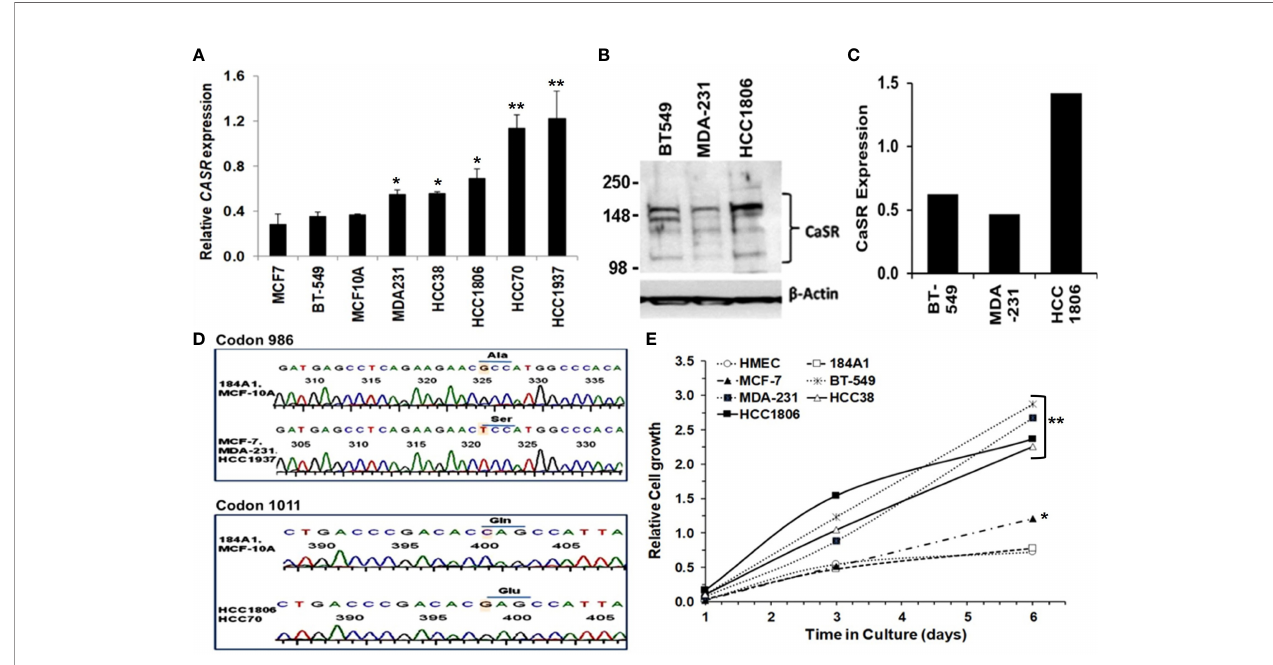
FIGURE 1 | Signi fi cance of CaSR variants in the growth and sensitivity of breast cancer cells to high Ca 2+ . (A) Expression of CASR in breast epithelial and breast cancer cell lines was assessed by reverse transcriptase and real-time PCR (RT-PCR). (B, C) Basal expression of CaSR in the indicated breast cancer cells was assessed by western blotting (B) and quanti fi ed by using the NIH ImageJ software (C) . (D) Genotyping of exon 7 mutations in breast epithelial and breast cancer cells by DNA sequencing of a 524 bp fragment. Shown are chromatograms depicting changes of the nucleotide sequence at codons 986 (Ala to Ser) and 1011 (Gln to Glu). (E) Effect of high Ca 2+ on the growth of breast epithelial and breast cancer cells in vitro . Cell proliferation/viability was assessed by using the PrestoBlue cell viability reagent. * denotes p < 0.05, ** denotes p <